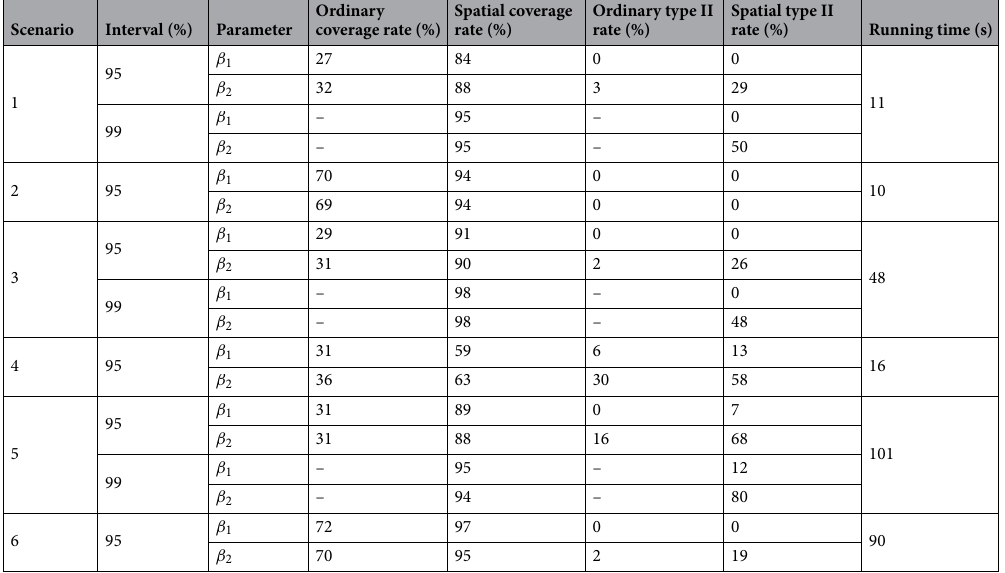
Table 2. Regression results for the simulation scenarios described in Table